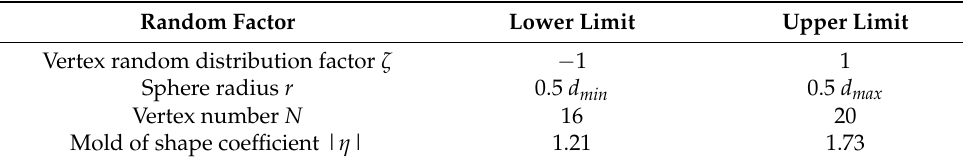
Table 2. The prediction error of some 2D thermal conductivity prediction models.